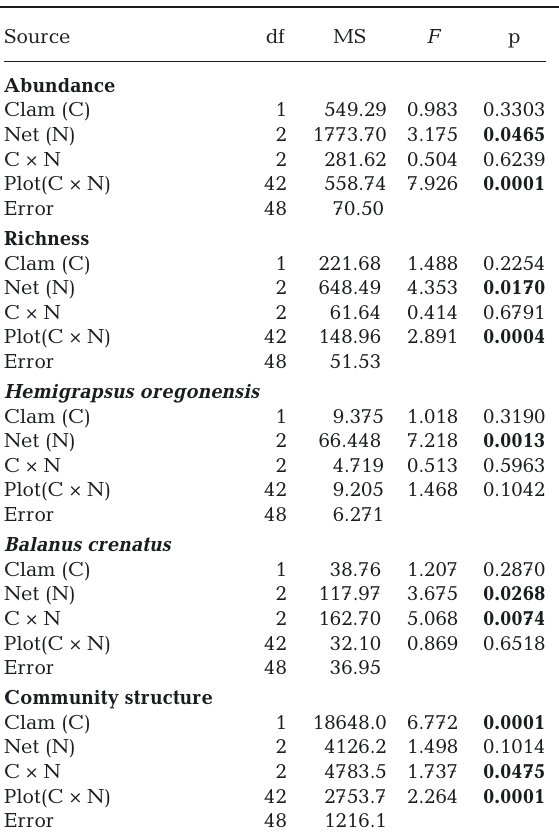
Table 2. Results of PERMANOVAs evaluating the effect of Clam (presence/absence), Net status (fouled, cleaned, or absent), and Plot (replicate plots for same treatment) on sediment macrofaunal community abundance and number of species (species richness). Significant effects (p < 0.05) are indicated in